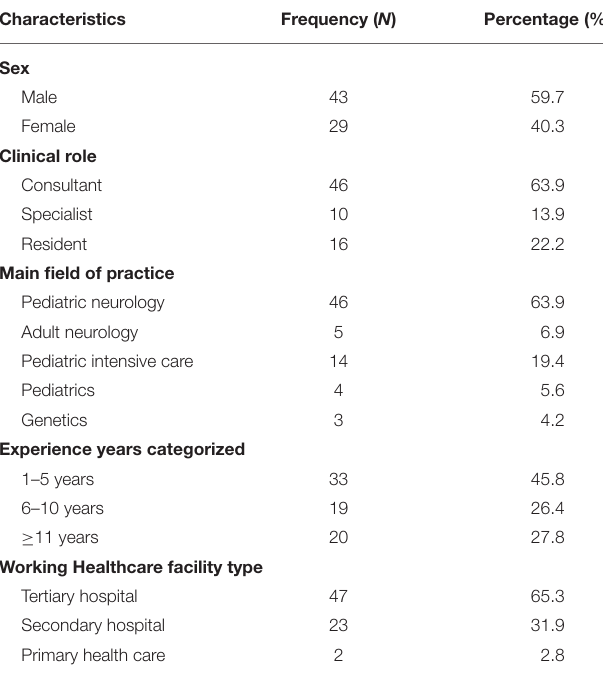
TABLE 2 | Practices and experience of physicians with SMA